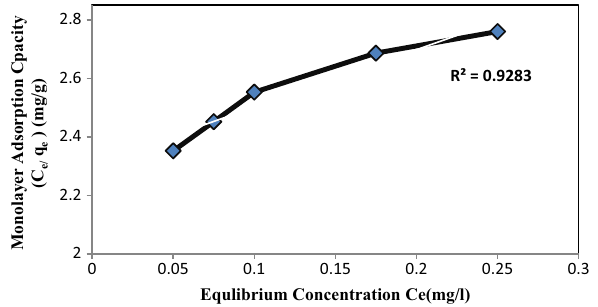
Fig. 7 Pseudo-first-order kinetics of HAp on arsenic of 0.3 mg/L at 120 rpm, temperature 30 °C and pH of 7